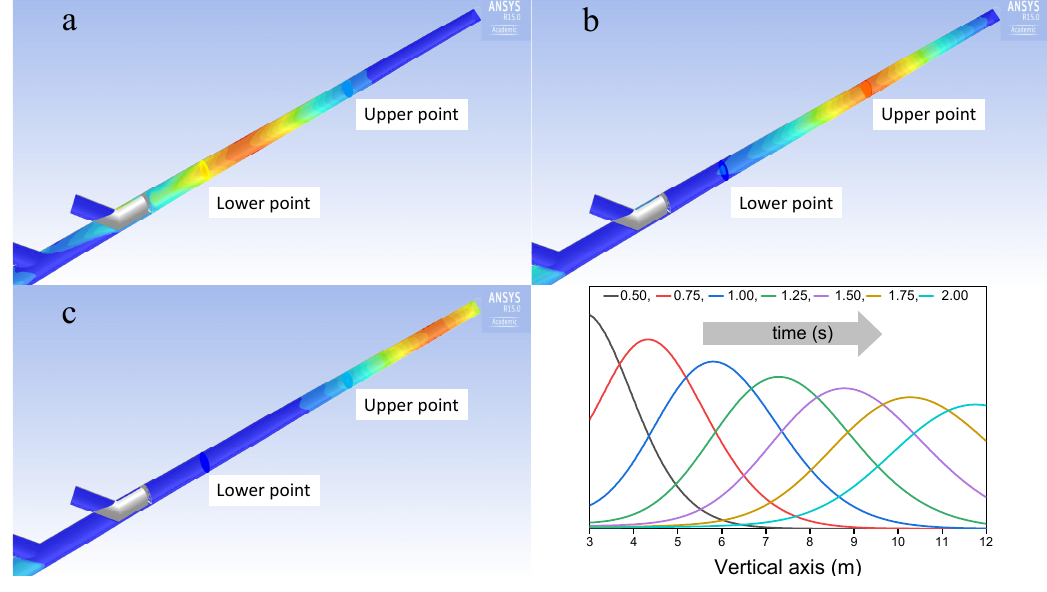
Figure 10. Computational fluid dynamic (CFD) tracer concentration profile along the stack axis (average velocity 6 m/s, T = 105 ◦ C). Time origin is the transit time of the tracer at the upper junction (grey in the figures). ( a ) 0.75 s; ( b ) 1.25 s; ( c ) 1.75